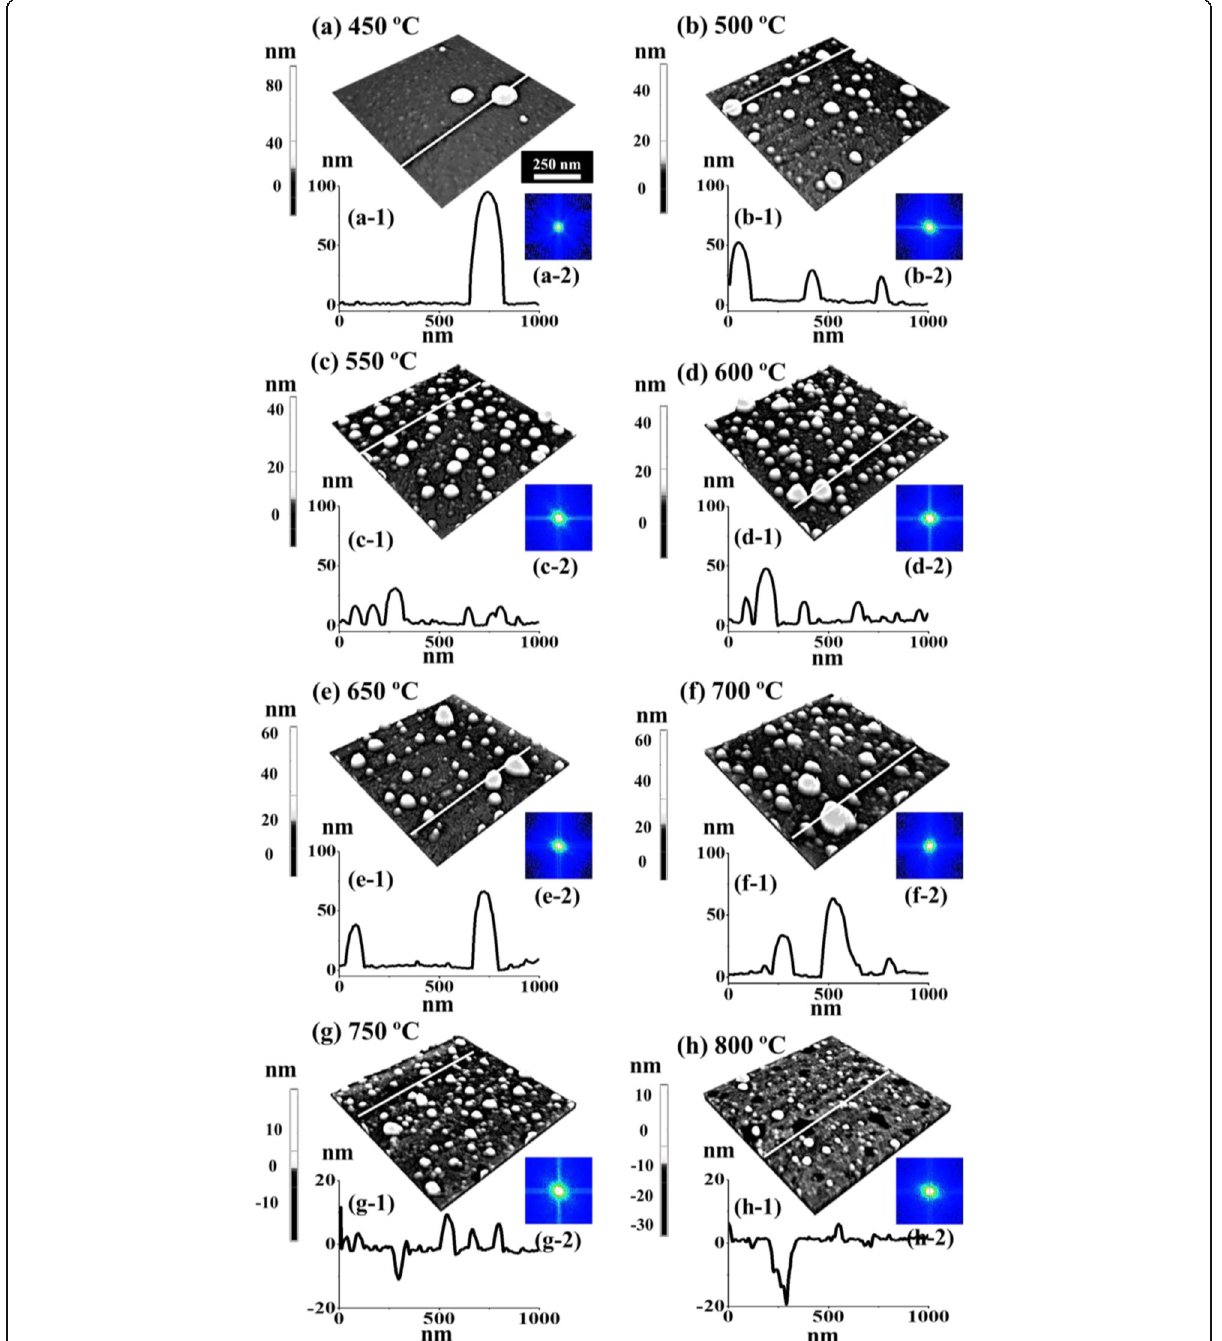
Fig. 6 Evolution of the self-assembled Pd NPs and nanoholes on Si by varying the AT between 450 and 800 °C with 5 nm deposition amount. a – h AFM side-views of 1 × 1 μ m 2 , with which the height of the Pd NPs is indicated with the color bars . ( a-1 ) – ( h-1 ) Cross-sectional line profiles ac- quired from the white lines in a – h . ( a-2 ) – ( h-2 ) Corresponding 2-D FFT power